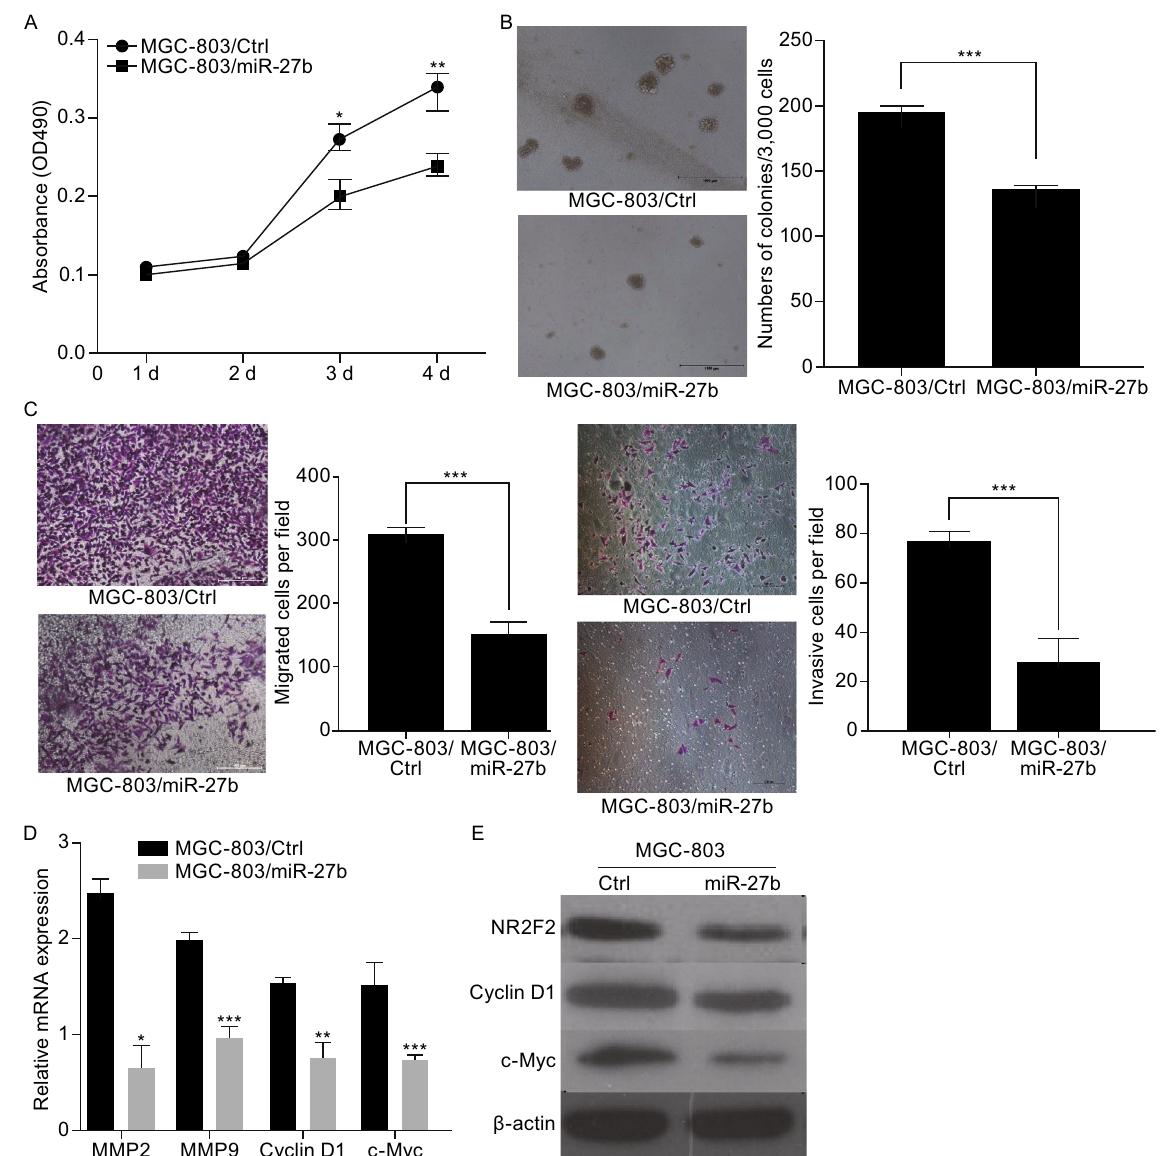
Figure 3. miR-27b inhibits gastric cancer cell growth, migration, and invasion in vitro . (A) The effect on cell proliferation of miR- 27b overexpression in MGC-803 cells was determined by the MTT assay. (B) Representative images show the colony formation of MGC-803/miR-27b and their control cells (left panel). Average colonies in each well for each group were counted from three independent experiments (right panel). (C) The effects of miR-27b overexpression in MGC-803 cells on cell migration and invasion were analyzed by Transwell migration and Matrigel-coated Transwell invasion analyses. (D) Q-RT analysis of proliferation and metastasis genes. (E) Western blot analysis of proliferation and metastasis genes. * P < 0.05, ** P < 0.01, *** P <